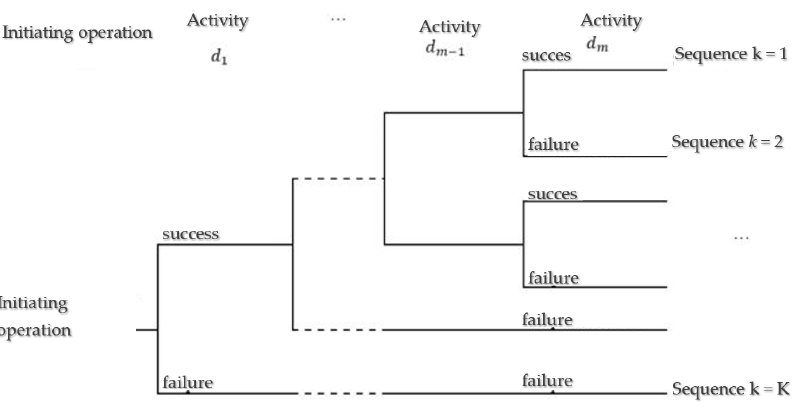
Figure 6. Event tree—general model [38].